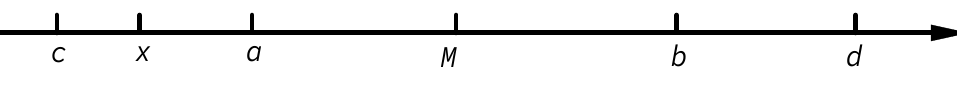
Figure 3. Linear relationship between the points x and M , and the intervals X and X 0 .